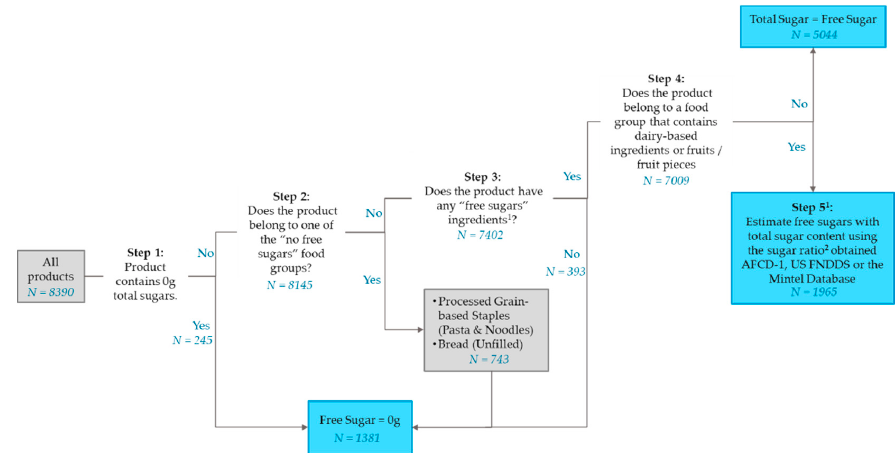
Figure 1. Free sugars imputation process for determining the free sugars content of products from the MintelDatabase. 1 “Free sugars” ingredients refers to sugar, maltodextrin, syrup, sucrose, glucose, fructose, maltose, honey, nectar, malt, non-dairy creamer, juice, jam, sweetened ingredients (e.g., sweetened fruits). 2 Sugar ratio refers to the ratio of free sugars:total sugars. This is the mean content of free sugars divided by the mean total sugars content of a product sub-category with dairy-based ingredients or whole fruit / fruit pieces. These were obtained from either the Australian Food Composition Database Release 1 (AFCD-1), US Food and Nutrient Database for Dietary Studies (FNDDS) or declared values from the Mintel